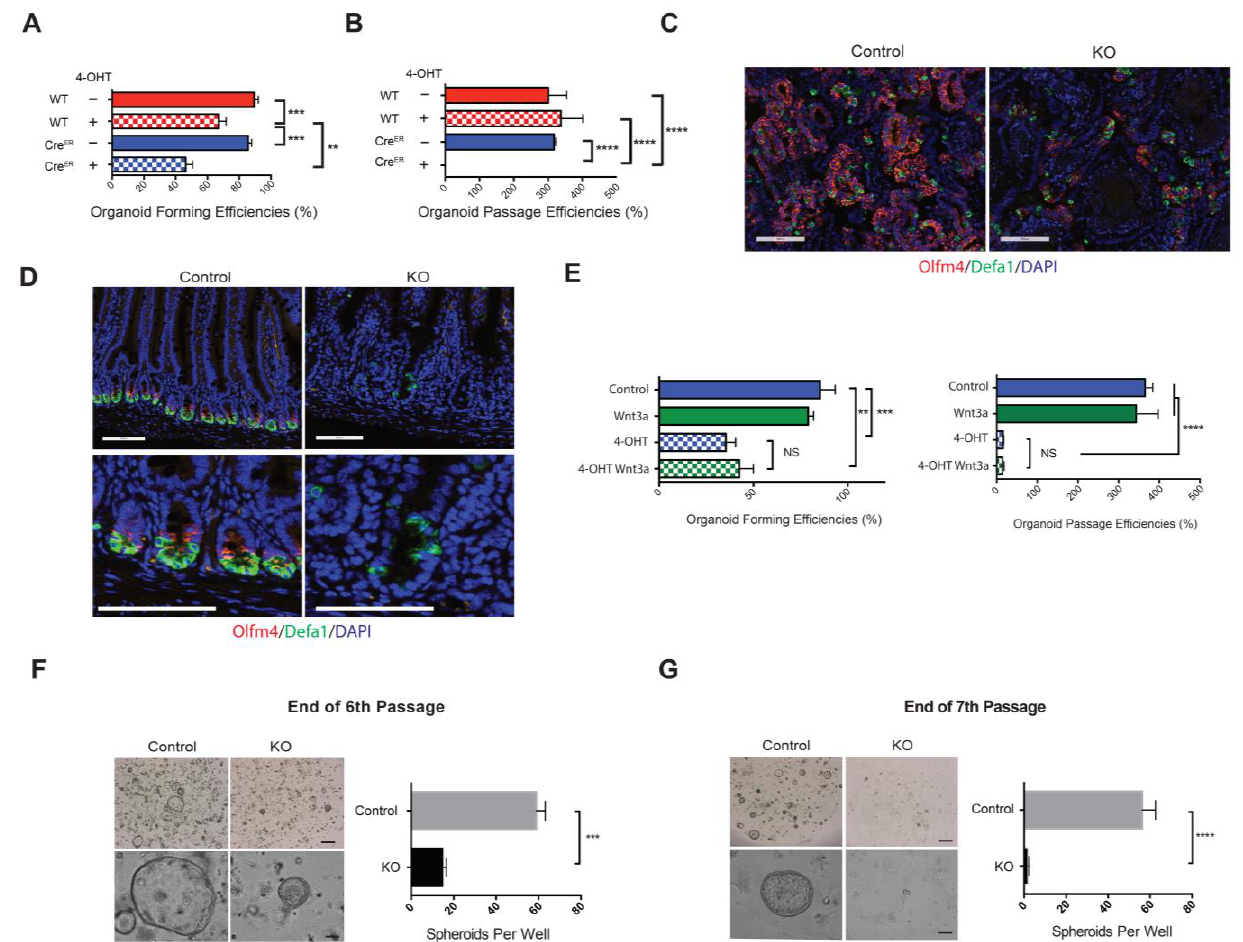
Figure 5. Effects of EpCAM loss on IEC stem cells and/or stem cell function. ( A ) KO organoids form less efficiently than control organoids. Efficiencies represent ratios of organoid numbers/well at Day 9 over crypt numbers/well on Day 1. Aggregate data from 3 independent experiments are depicted. ** p < 0.01 and *** p < 0.001 via Student’s t test. ( B ) KO